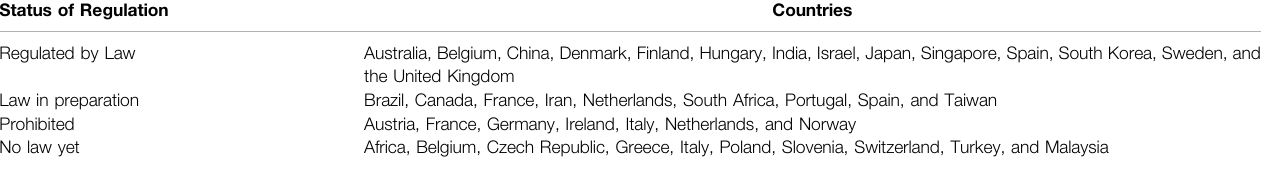
TABLE 5 | The regulation of RMT in clinical application and research according to